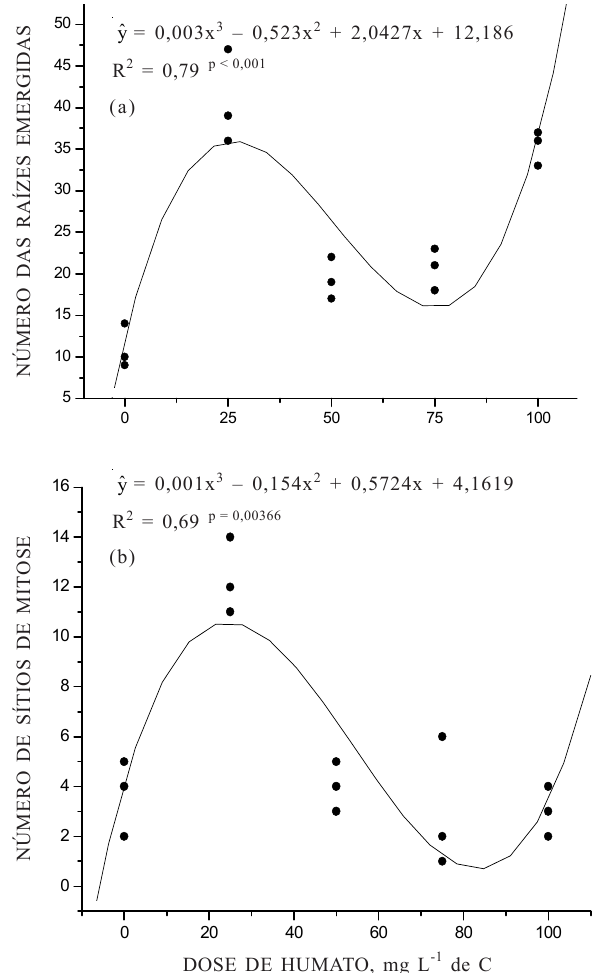
Figura 2. Número de raízes laterais emergidas (a) e de sítios de mitose (b) em plântulas de alface.